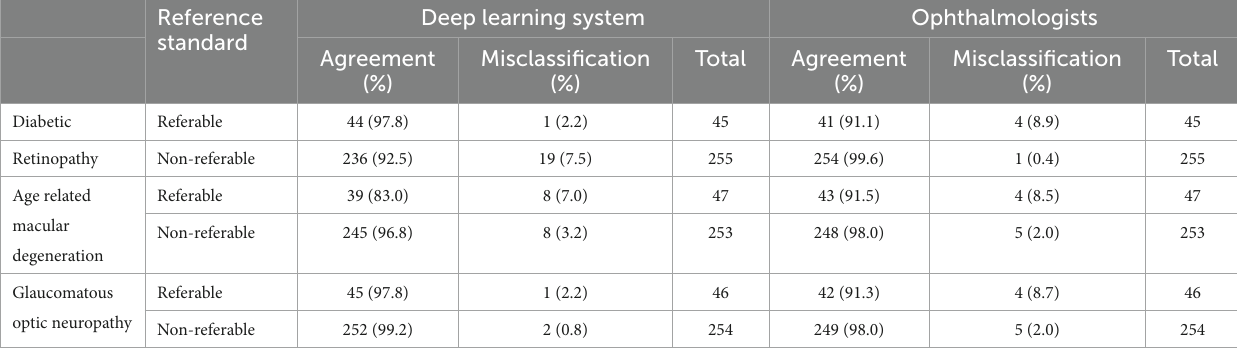
TABLE 2 Comparison of deep learning system and general ophthalmologists to the expert consensus reference